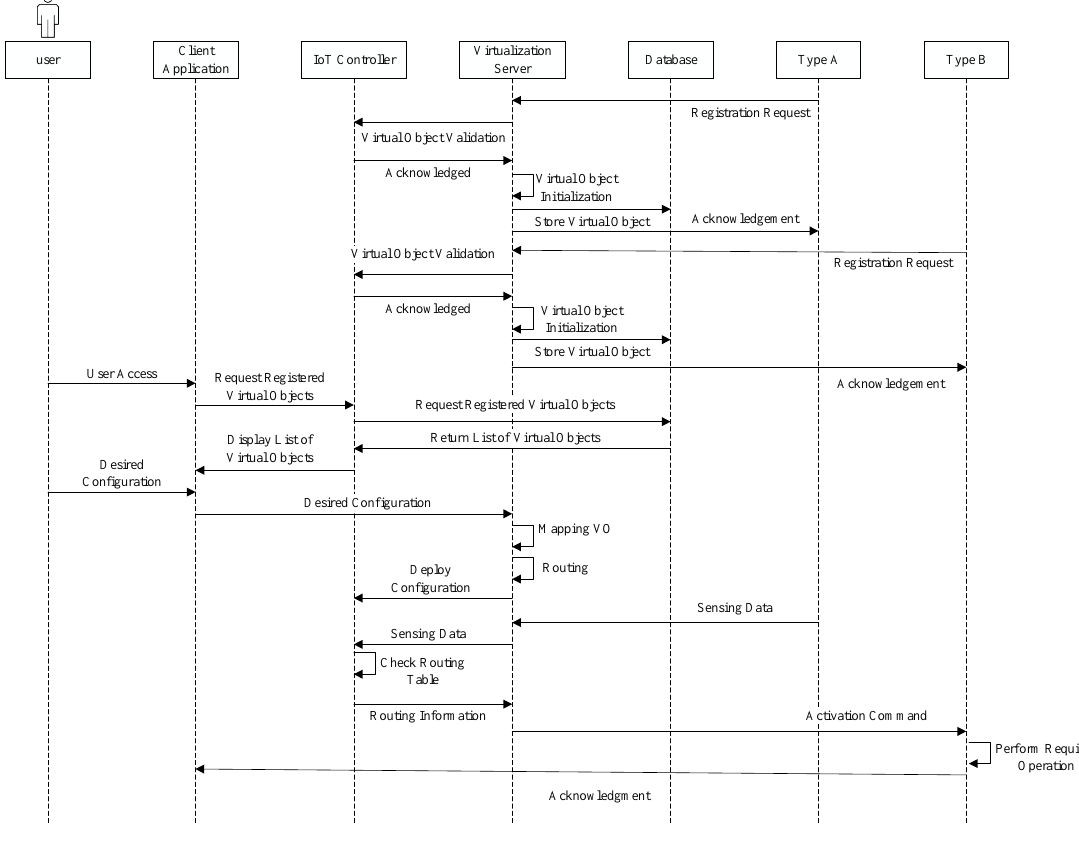
Figure 5. Sequence Diagram for Virtual IoT